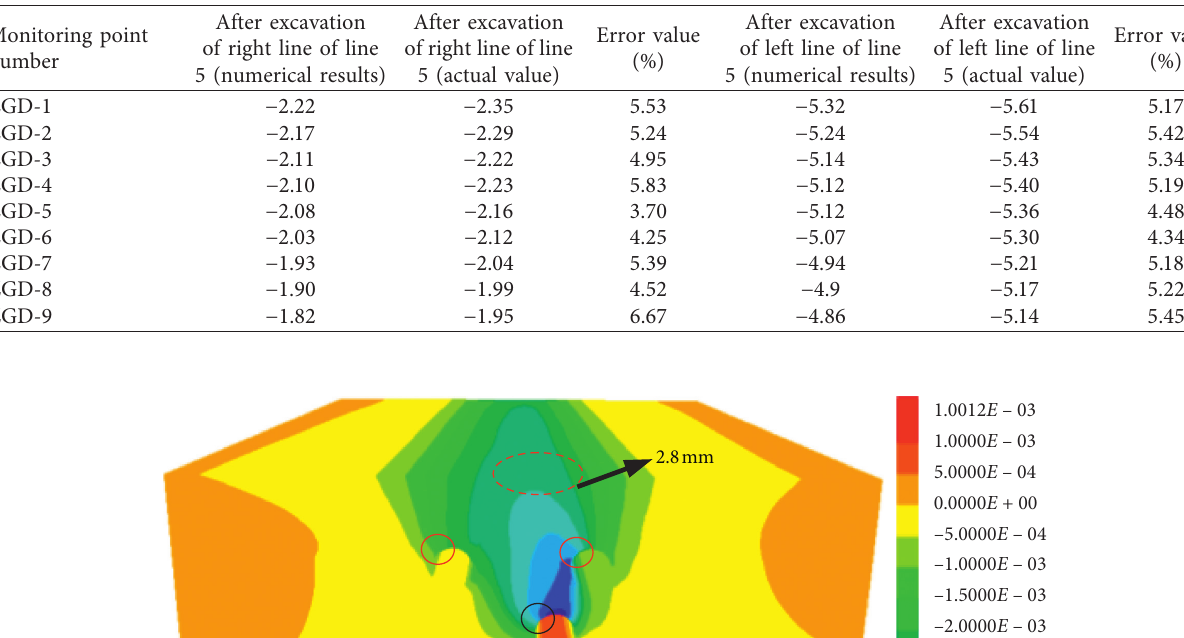
Table 3: The comparative analysis results of the maximum settlement and error of the vault.